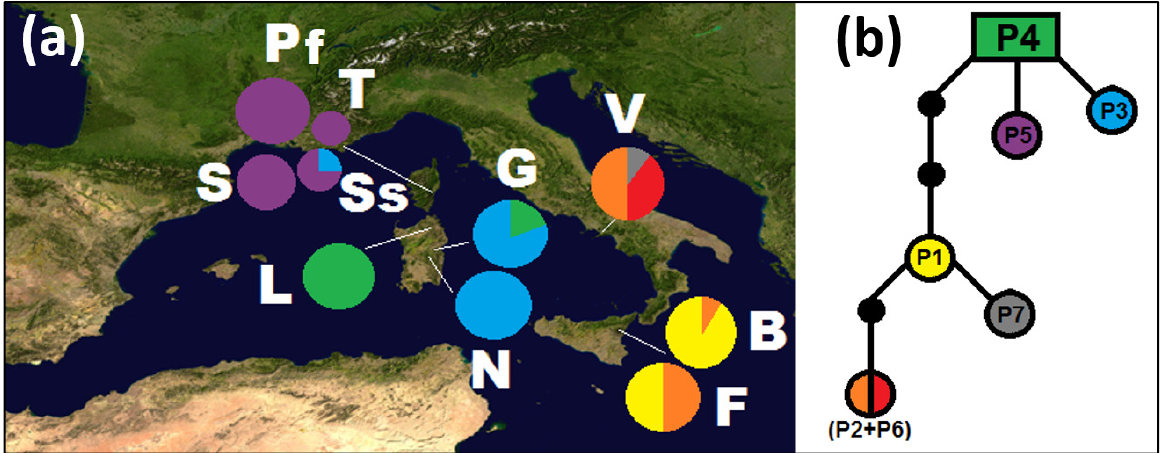
Figure 1. ( a ) Distribution map of the populations of Genista etnensis and the relative frequency of haplotypes (cpDNA) (populations labels: B = Mount Baracca, F = Fornazzo, G = Genna Silana, L = Mount Limbara, N = Villagrande Strisaili, Pf = Serra Fiumorbu, S = Solenzara, Ss = road between Sari and Solenzara, T = Solaro, V = Mount Vesuvius); ( b ) haplotype genealogies as inferred by TCS software (indels scored as missing data); black dots represent undetected haplotypes.